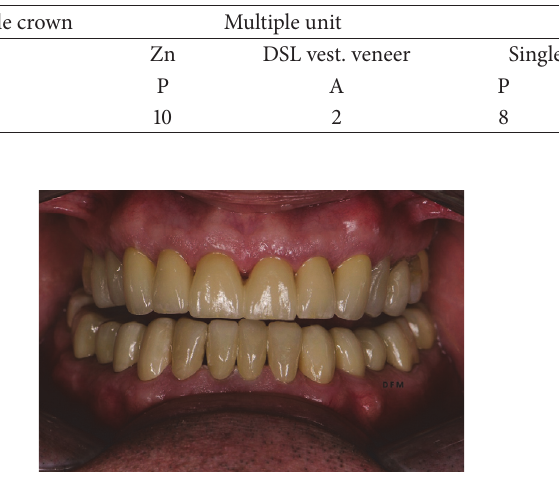
Figure 7: Clinical intraoral result after